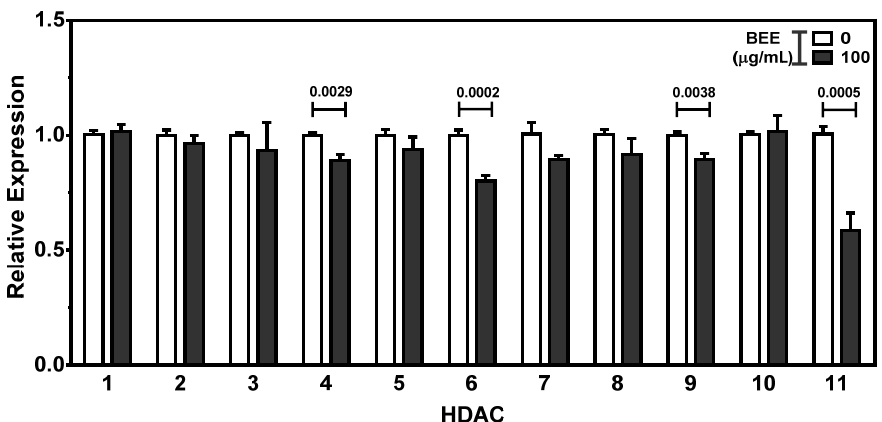
Figure 5. The effects of BEE on the regulation of HDACs in HepG2 cells. The cells were treated with 100 μ g/mL of BEE for 24 h. The expression of HDAC isoforms was measured by qRT-PCR. Data are expressed as relative expressions of control. Different letters indicate significant differences ( p < 0.05). Values are means ± S.E.M. n = 6.